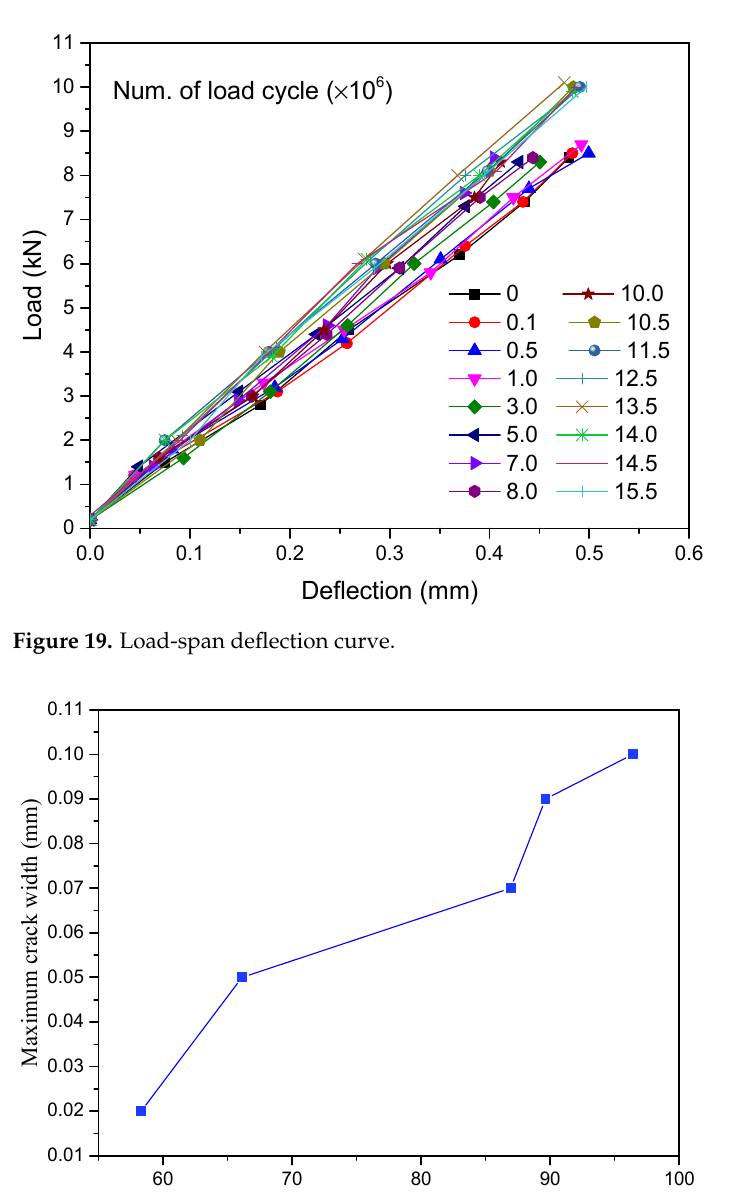
( a ) Crack distribution on the top surface of UHPFRC ( b ) Crack distribution on the side of UHPFRC Figure 21. Crack distribution of specimen. As can be seen from the above research, the LWCD with 60-mm UHPFRC layer and 25-mm cover thickness has excellent flexural and fatigue performance and can meet the engineering design requirements. 7. Conclusions This paper studies the influence of main design parameters on longitudinal bending performance and the transverse bending fatigue behavior of LWCD via FEA and full-scale